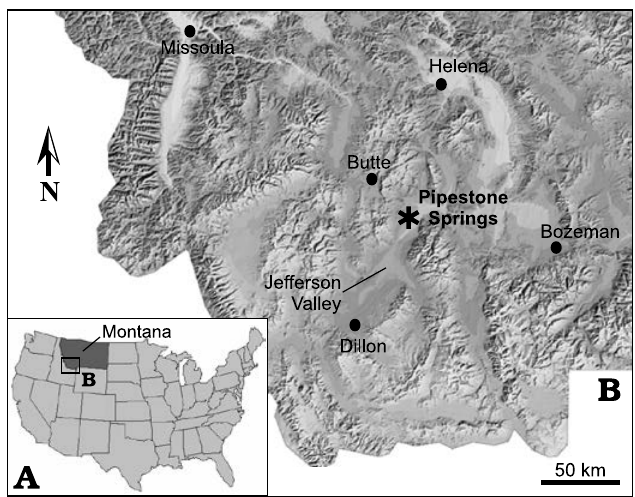
Fig. 1. Study area location maps. A . Location of studied area within Montana (USA). B . Digital relief image of southwest Montana depicting main towns and the Jefferson Valley which contains the study locality of Pipestone Springs (sourced from Montana State Library, Natural Resource Information System, 2001 data